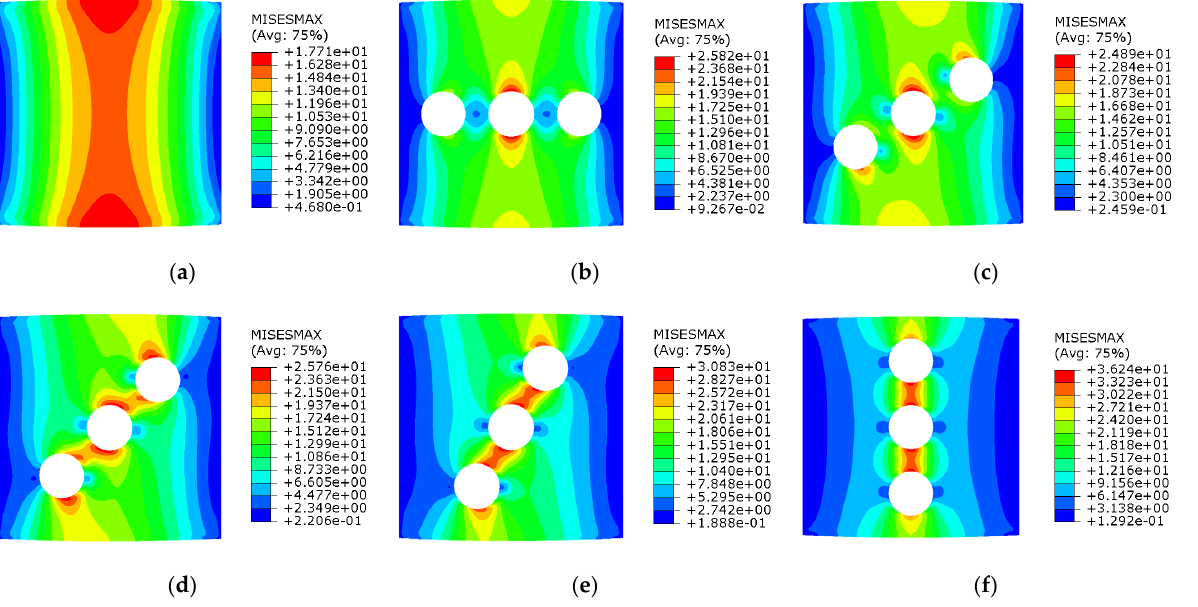
Figure 7 . Von Mises stress of FGM plates with ( a ) a plate thickness of 50 mm, a cutout diameter of 400 mm with an arrangement of ( b ) 0 ° , ( c ) 30 ° , ( d ) 45 ° , ( e ) 60 °, and ( f ) 90 °. In addition to the critical buckling loads and the Von Mises stresses, the analysis pro ‐ vides the buckling modes of the FGM plate. The buckling mode analysis shows the distri ‐ bution of the buckling stress in the FGM thin plate. Generally, the maximum stress should be seen in the regions surrounding the cutouts. Figure 8 shows the first five buckling modes of the FGM plate with a thickness of 25 mm and a cutout diameter of 200 mm for various cutout arrangements. On the other hand, Figure 9 shows the first five buckling modes of the FGM plate with a thickness of 25 mm and a cutout diameter of 300 mm for various cutout arrangements. Finally, Figure 10 shows the first five buckling modes of the FGM plate with a thickness of 25 mm and a cutout diameter of 400 mm for various cutout arrangements.